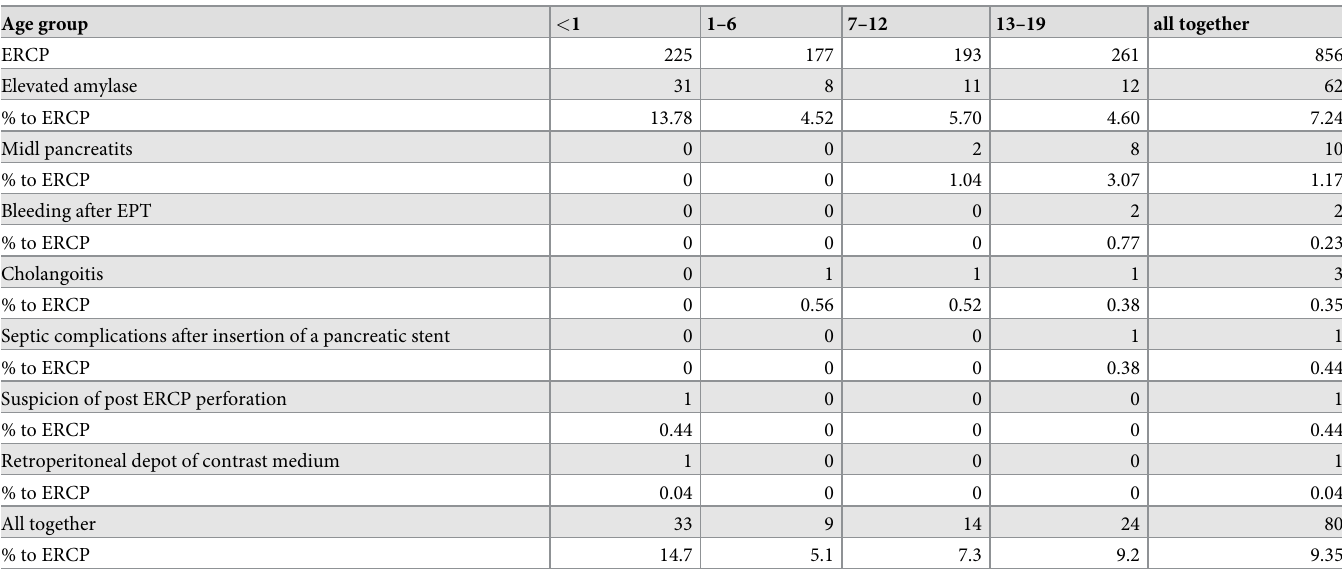
Table 5. Distribution of complications in age